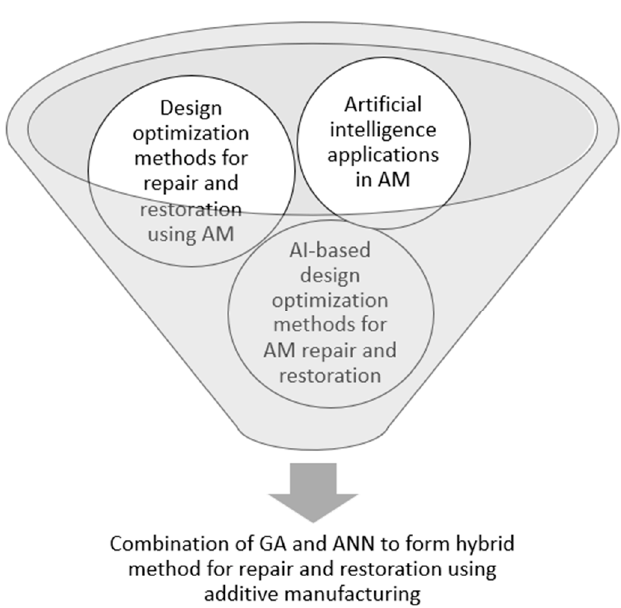
Figure 11. Recommendation for the hybrid method of repair and restoration using AM.